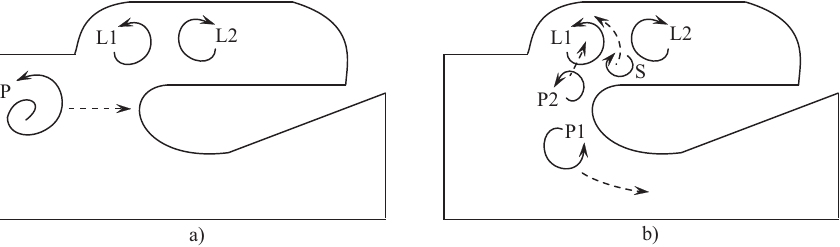
Figure 21. Formation ( a ) and development ( b ) of vortical structure of the